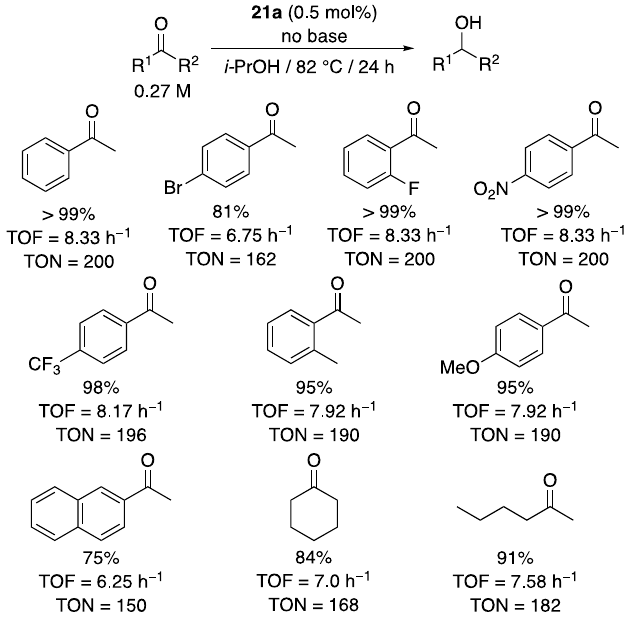
Scheme 11. Base-free TH of ketones catalyzed by 21a